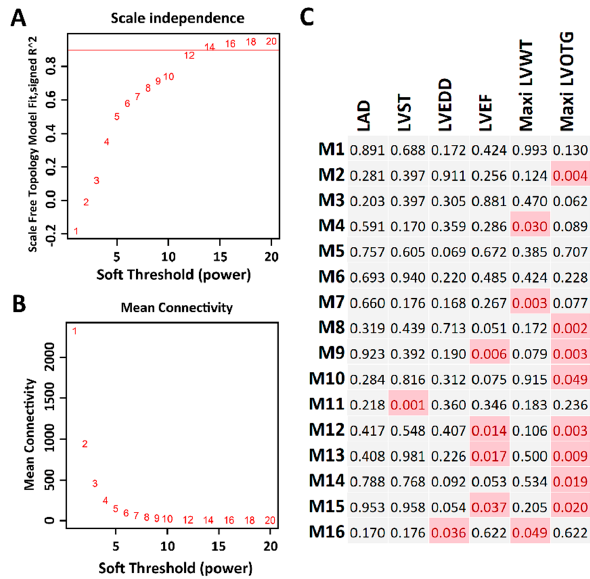
Figure 6. Co-expression network analysis. ( A ) The soft thresholding index R 2 ( y -axis) as a function of the different thresholding power β ( x -axis). ( B ) Mean connectivity ( y -axis) as a function of the power β ( x -axis). ( C ) Sixteen co-expression modules identified from the myocardial RNA-seq dataset. Each cell represents the correlation coefficient p -value computed from correlating the module eigengenes to the clinical traits (columns). Cells filled with red represent significant associations between modules and traits ( p < 0.05).